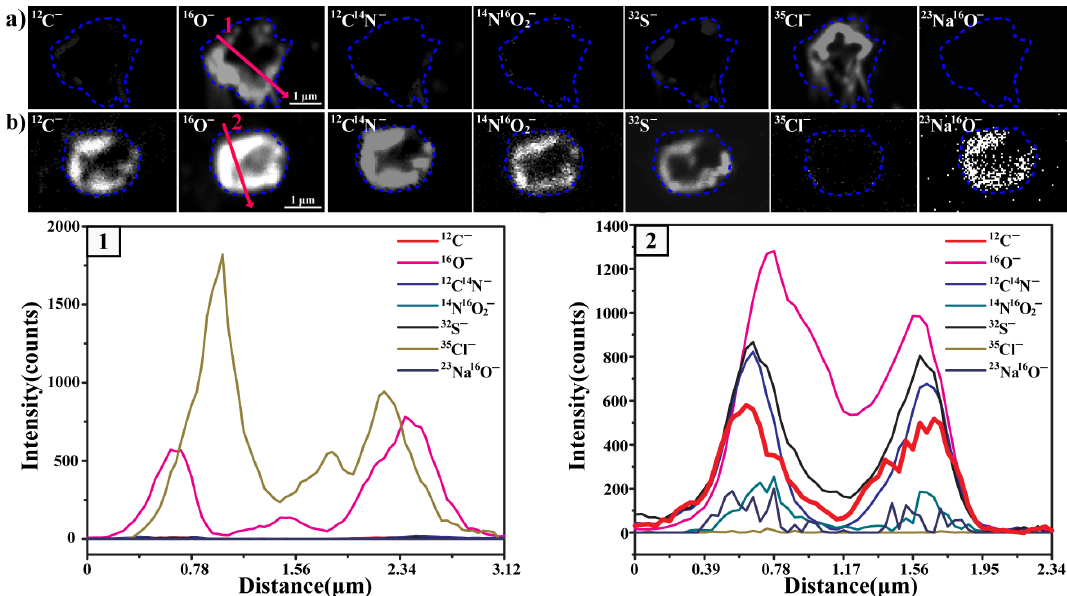
Figure 9. NanoSIMS-based ion intensity mappings. Mappings of 12 C − , 16 O − , 12 C 14 N − , 14 N 16 O − one fresh SSA particle (a) and one fully aged SSA (b) . Lines 1–2 represent the line scanning on the surfaces of individual particles. The red line represents the profile of 12 C − in fully aged